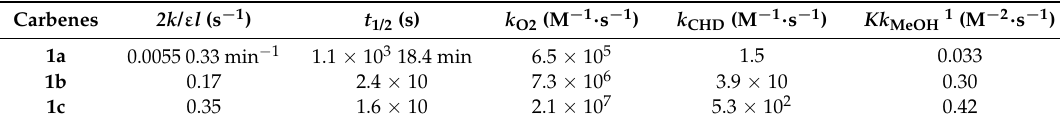
Figure 3. Absorption of transient products formed during laser irradiation ( λ = 308 nm) of 1a -N 2 in degassed benzene at 25 ◦ C recorded from immediately after irradiation to 90 min after irradiation. The inset shows the time course of the absorption monitored at 366 nm. Table 1. Kinetic Data of Carbenes 1 .